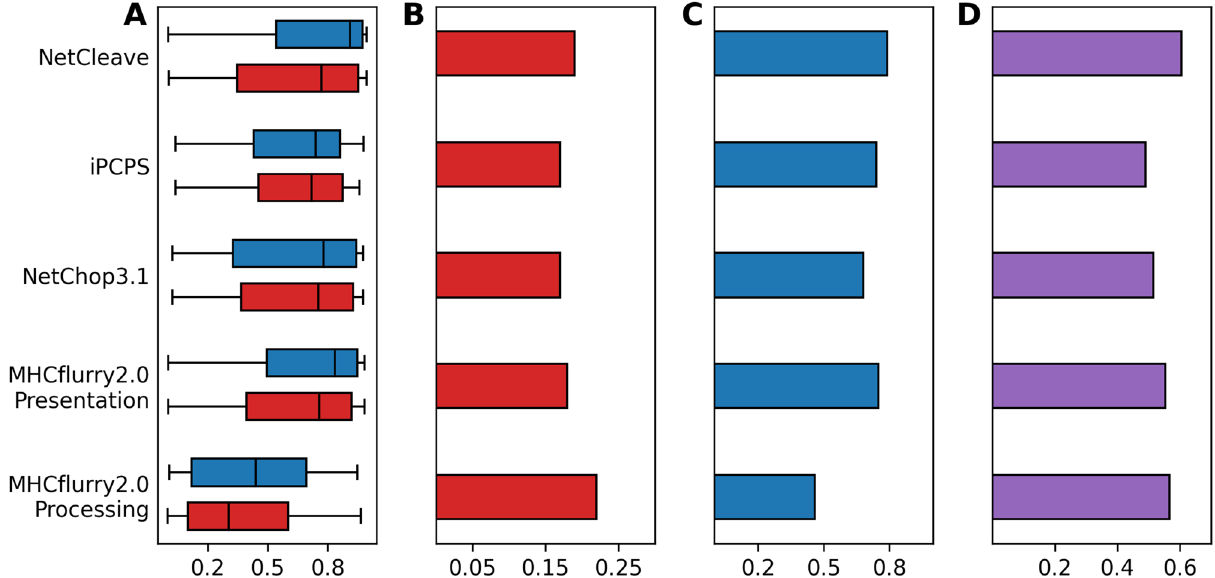
Figure 5. Immunogenicity benchmark of NetCleave, iPCPS, NetChop3.1, MHCflurry2.0 presentation and MHCflurry2.0 processing scores for HLA-B*07:02 dataset. ( A ) Prediction distribution for immunogenic